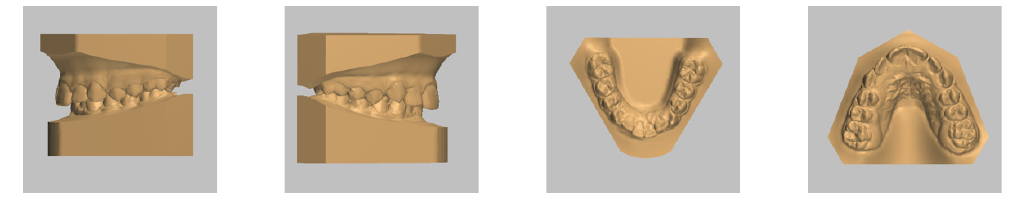
Figure 5. Pre-treatment digital models registered the centric dental position.